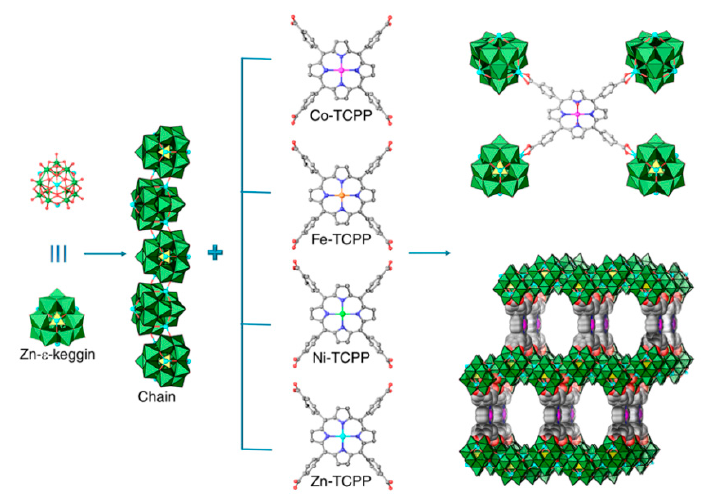
Figure 13. Schematic illustration of the structures of M-PMOFs (Polyoxometalate-Metalloporphyrin Organic Frameworks). Color code: MoO 6 octahedra, bottle green; Zn, light blue ball; Ni, green ball; Fe, orange ball; Co, magenta ball, N, blue ball; C, grey ball; O, red ball; H was omitted. Reprinted with permission from [58]. Copyright © 2015 Attribution 4.0 International (CC BY 4.0). Table 6. CO 2 electroreduction performances a.